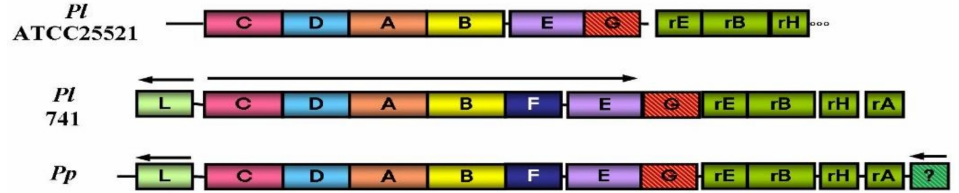
Figure 2. The gene organization of lux operon region in bioluminescence bacteria of Photobacterium species. Photobacterium leiognathi ATCC 25,521 (Pl), Photobacterium leiognathi 741 (Pl), Photobacterium phosphoreum NCMB 844 (Pp). Arrow indicates the direction of transcription. ‘r’ represent for riboflavin and the functions of genes are shown in Figure